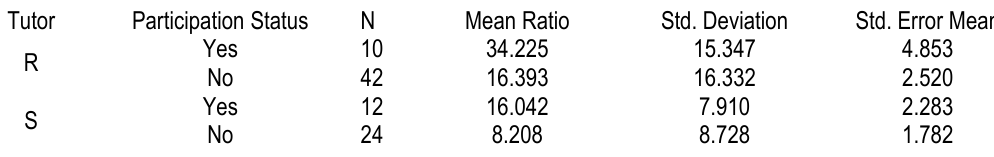
Table 5. Mean Score of the Final Exam Score of Learners Who Have Participated in the Pre- instructional Workshop and Learners Who Have Not